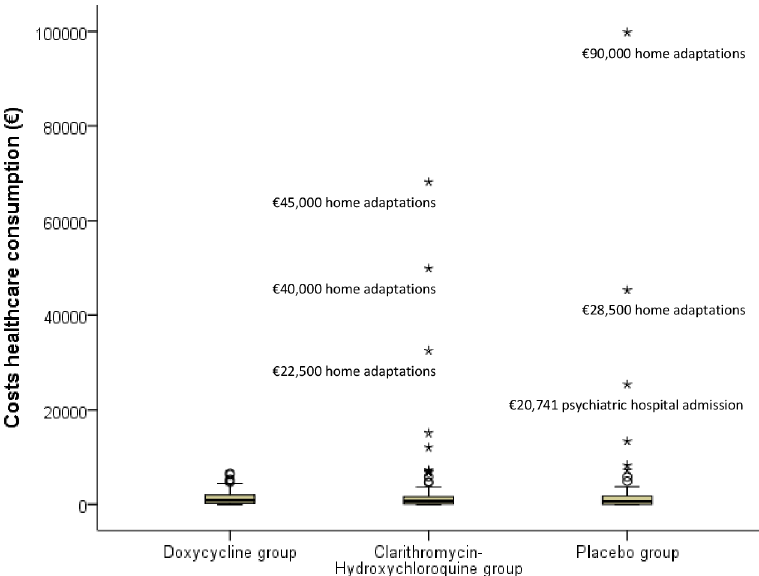
Fig 2. Distribution of the costs of healthcare consumption in the three treatment groups, including explanation of the largest outliers.